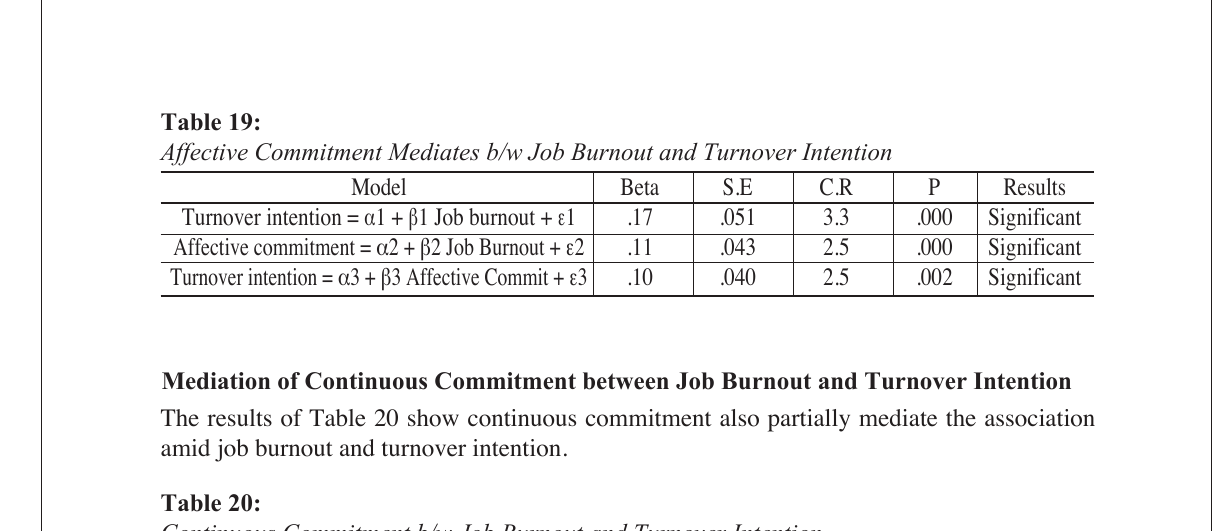
The results of Table 20 show continuous commitment also partially mediate the association